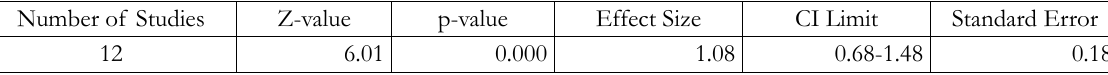
Table 5. Overall Effect